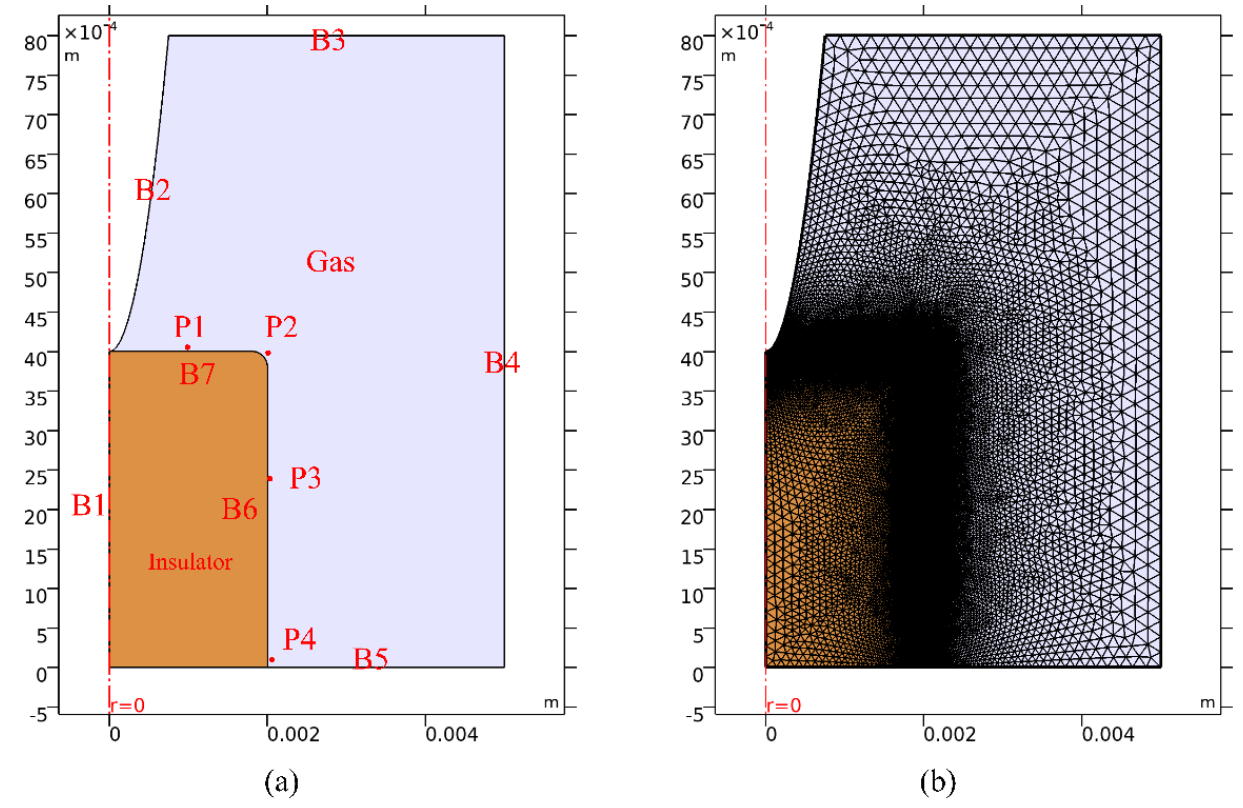
Figure 2. Simulation geometry ( a ) and mesh ( b ) of the discharge model.